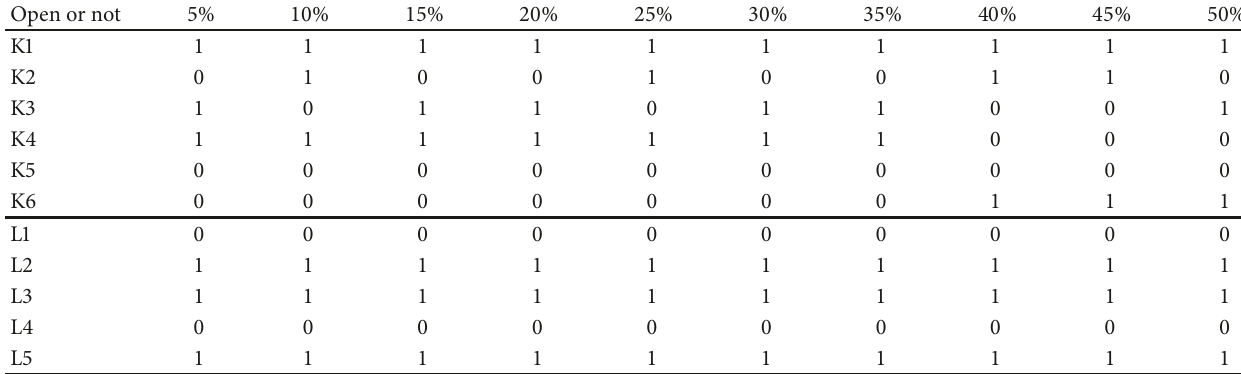
Table 17: Impact of transportation cost coefficients’ variance on choice of opening